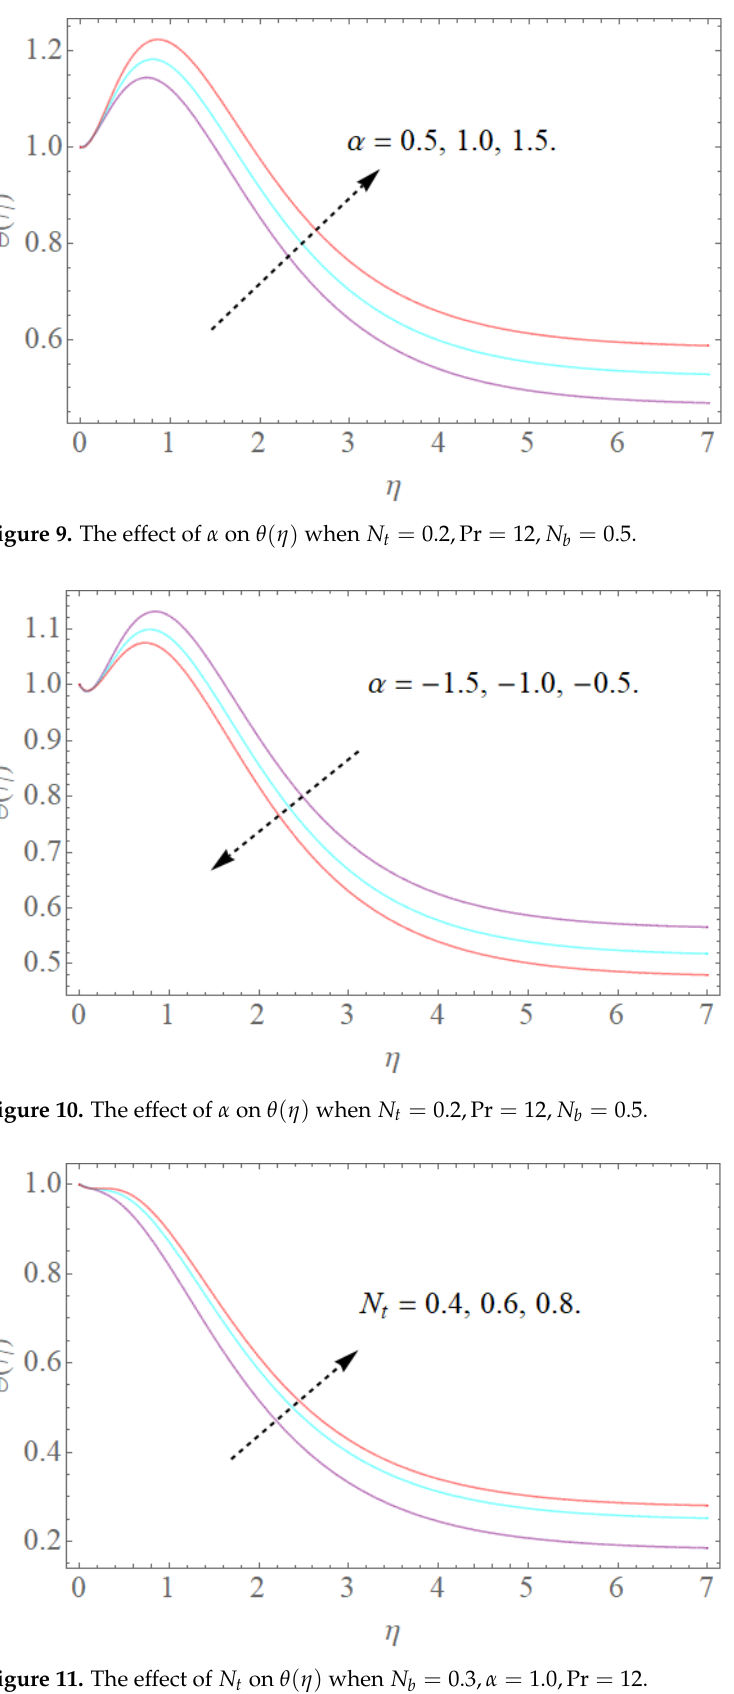
Figure 8. The effect of Pr on